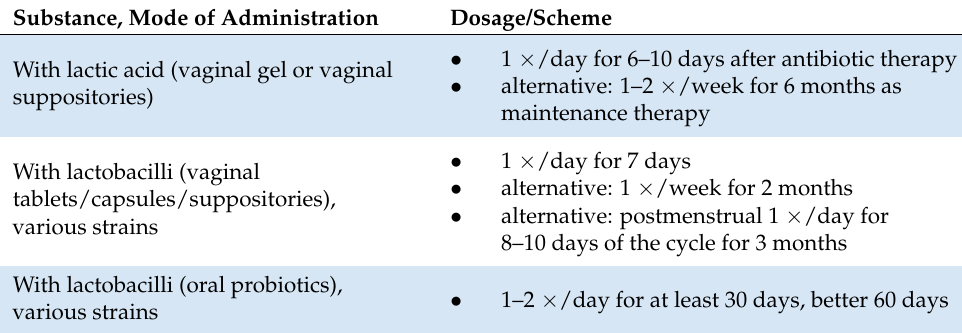
Table 4. Treatment options with lactic acid and substances with Lactobacilli